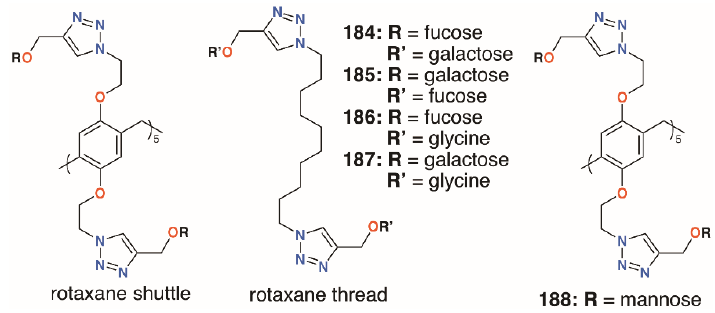
Figure 30. Nierengarten’s pillar[5]arene rotaxanes.